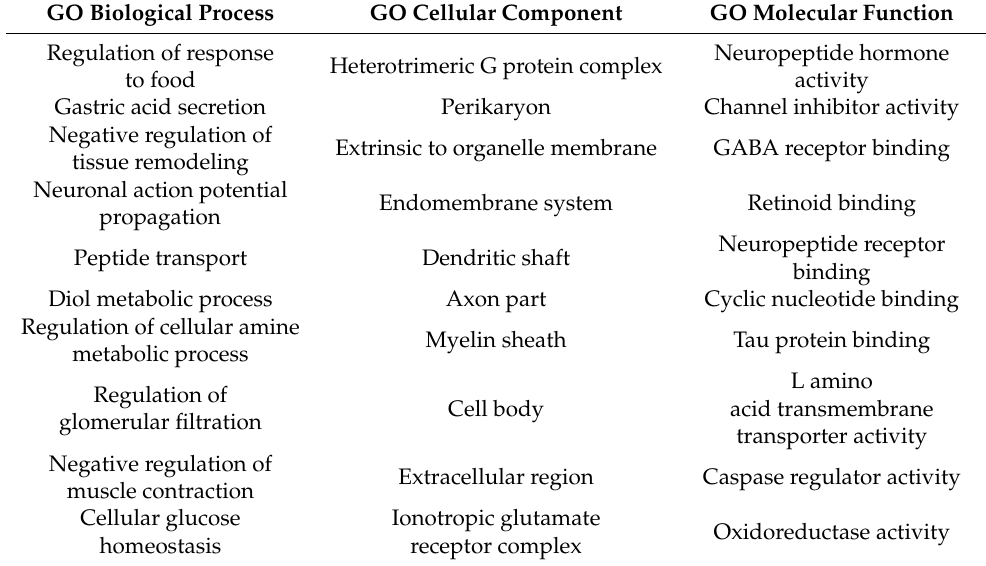
Table 9. Top 10 GO biological processes, cellular components, and molecular functions enriched from differentially expressed genes that are downregulated in MMC spinal cords compared to vehicle at E17. All GO pathways were >1.5-fold and p <